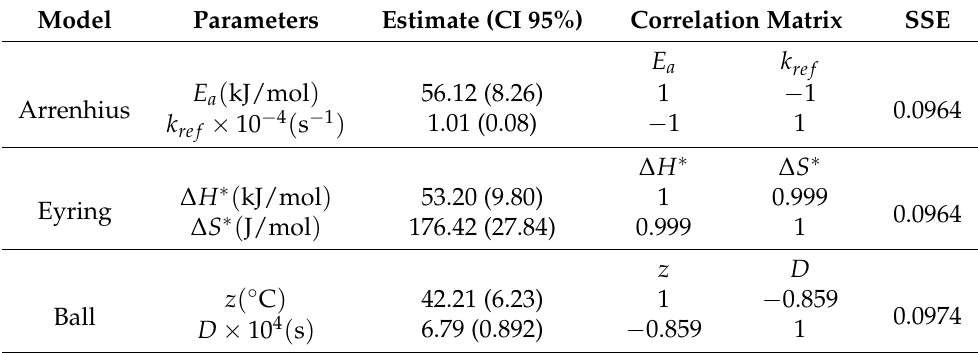
Table 2. Parameters for the thermal degradation of anthocyanins, following different